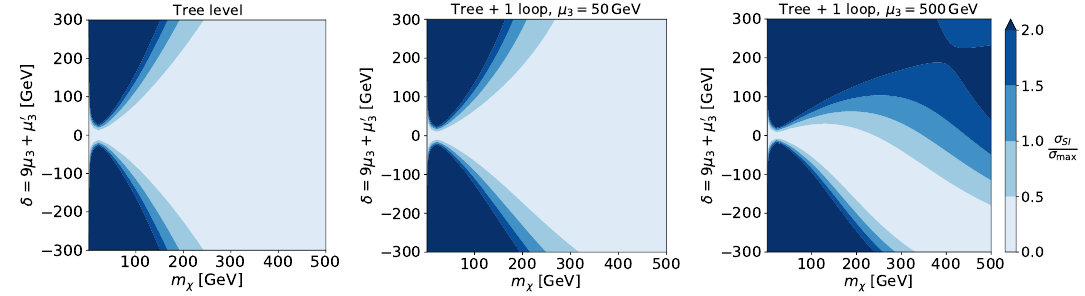
Figure 4 . Cancellation regions for the DM-nucleon interaction cross section, regardless of the relic density contributions; contours show the value for (cid:27) SI over the XENON1T limit cross section, (cid:27) max , meaning that the contours showing a value less than one pass the direct-detection bounds. Here, we have set w = 250 GeV, m 2 = 200 GeV and sin (cid:18) = 0 : 1. Note that all other symmetry-breaking terms not explicitly presented in the plot are set to zero: (cid:22) 1 = (cid:22) HS = 0 GeV and (cid:21) 0